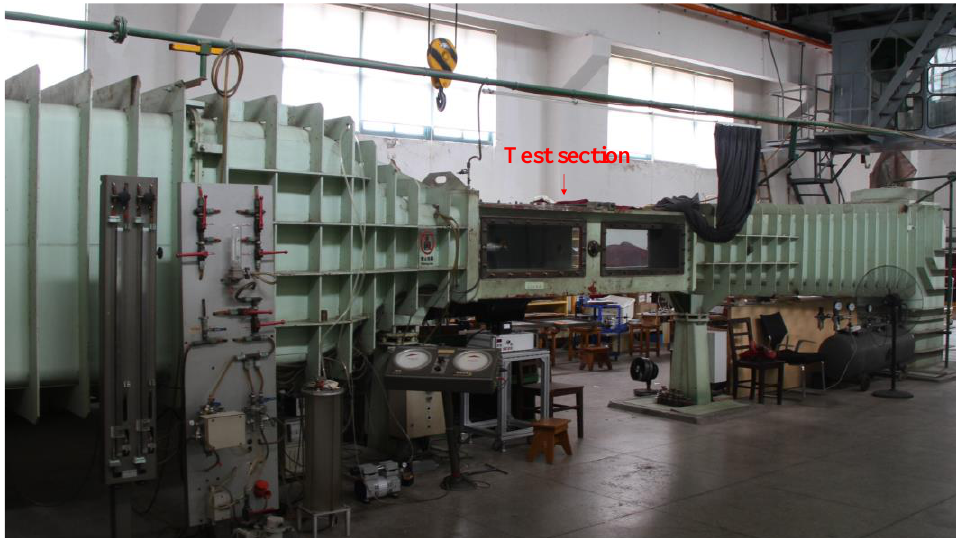
Figure 4. The test section of the cavitation tunnel.